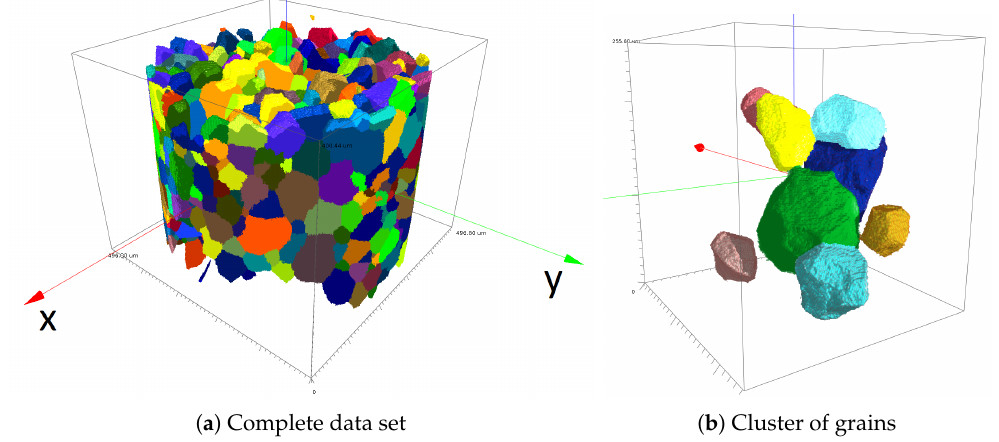
Figure 8. Rendering of the DCT image data of the titanium sample. The imaged cylinder has a diameter of 518 µm and a height of 400 µm. In ( a ), boundary grains on top and bottom are removed to emphasize the shape and packing of grains. Subfigure ( b ) shows a cluster of grains from this data set. The grain colors are randomly chosen in order to visually separate neighboring grains and their